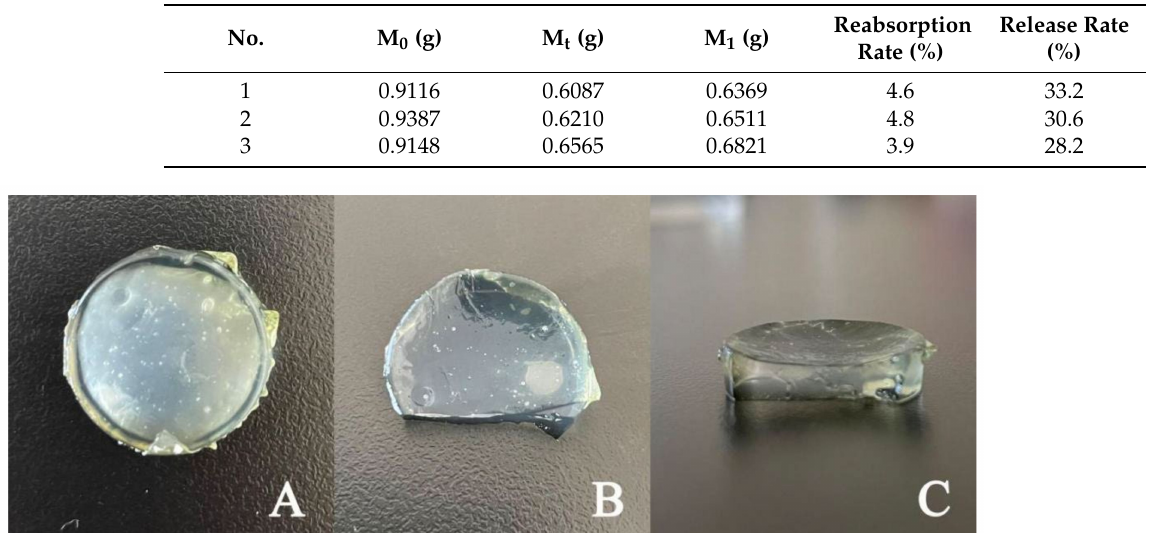
Table 3. Reabsorption rate and release rate of hydrogel after pulse release.